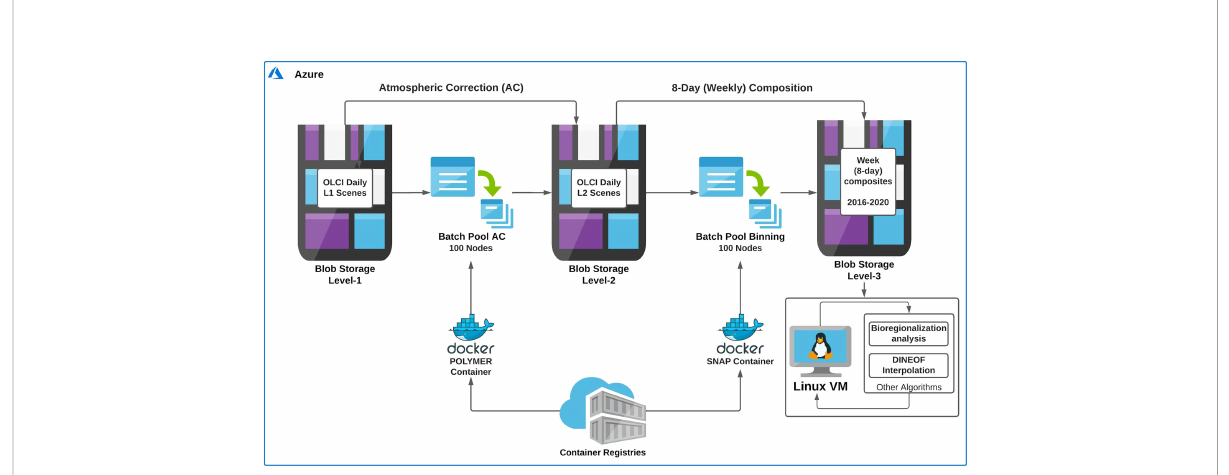
FIGURE 2 Work fl ow showing the main steps (i.e., atmospheric correction and binning) made on the Microsoft Azure cloud computing platform to obtain the Sentinel-3A Level-3 time series. The chlorophyll-a Level-1 dataset (~ 8000 scenes) was submitted to the atmospheric correction (AC) using POLYMER processor (v 4.10) to generate the Level-2 dataset. The latter was binned to create the 8-day chlorophyll-a Level-3 dataset with 300 m spatial resolution. All the tasks were made in parallel (i.e., using a pool of 100 CPU cores) and executed in speci fi c containers. Finally, the DINEOF interpolation procedure and subsequent analyses were performed using a virtual machine within the Azure cloud platform. Note that the DINEOF output led to the generation of a cloud-free time series of 8-day composite chlorophyll-a images. For detailed information on the whole work fl ow, see section